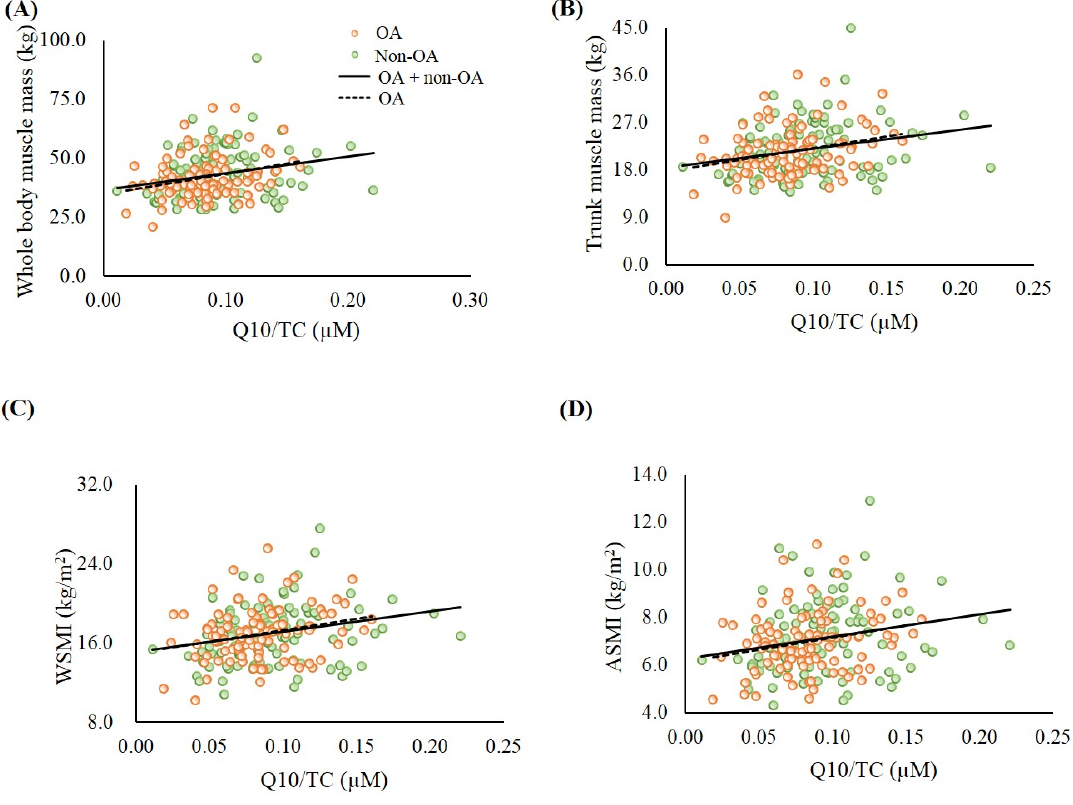
Figure 2. Correlations between coenzyme Q10 status and muscle mass. ( A ) Correlation between coenzyme Q10 status and whole-body muscle mass. OA group: r = 0.27, p < 0.01; OA + non-OA group: r = 0.24, p < 0.01; ( B ) Correlation between coenzyme Q10 status and trunk muscle mass. OA group: r = 0.24, p = 0.02; OA + non-OA group: r = 0.24, p < 0.01; ( C ) Correlation between coenzyme Q10 status and WSMI. OA group: r = 0.26, p < 0.01; OA + non-OA group: r = 0.26, p < 0.01; ( D ) Correlation between coenzyme Q10 status and ASMI. OA group: r = 0.24, p = 0.02; OA + non-OA group: r = 0.24, p < 0.01. ASMI, appendicular skeletal muscle mass index; OA, osteoarthritis; TC, total cholesterol; WSMI, whole skeletal muscle mass index.